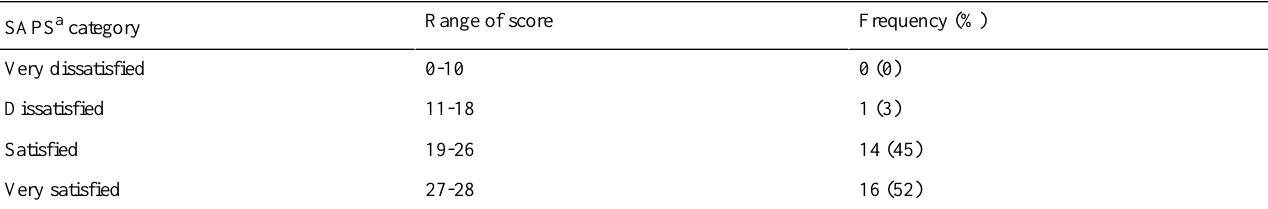
Table 5. Overall Short Assessment of Patient Satisfaction scores categorized according to “Very dissatisfied,” “Dissatisfied,” “Satisfied,” and “Very Satisfied” for patients who sought hearing health care